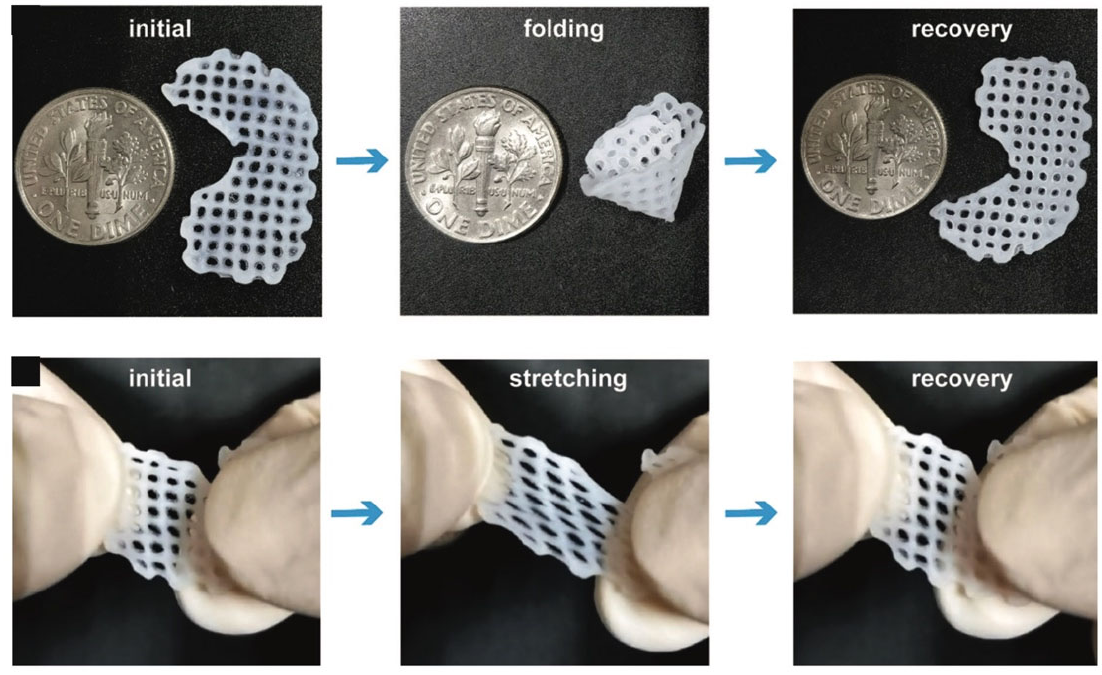
Figure 8. The folding and stretching of a bioprinted scaffold [149]